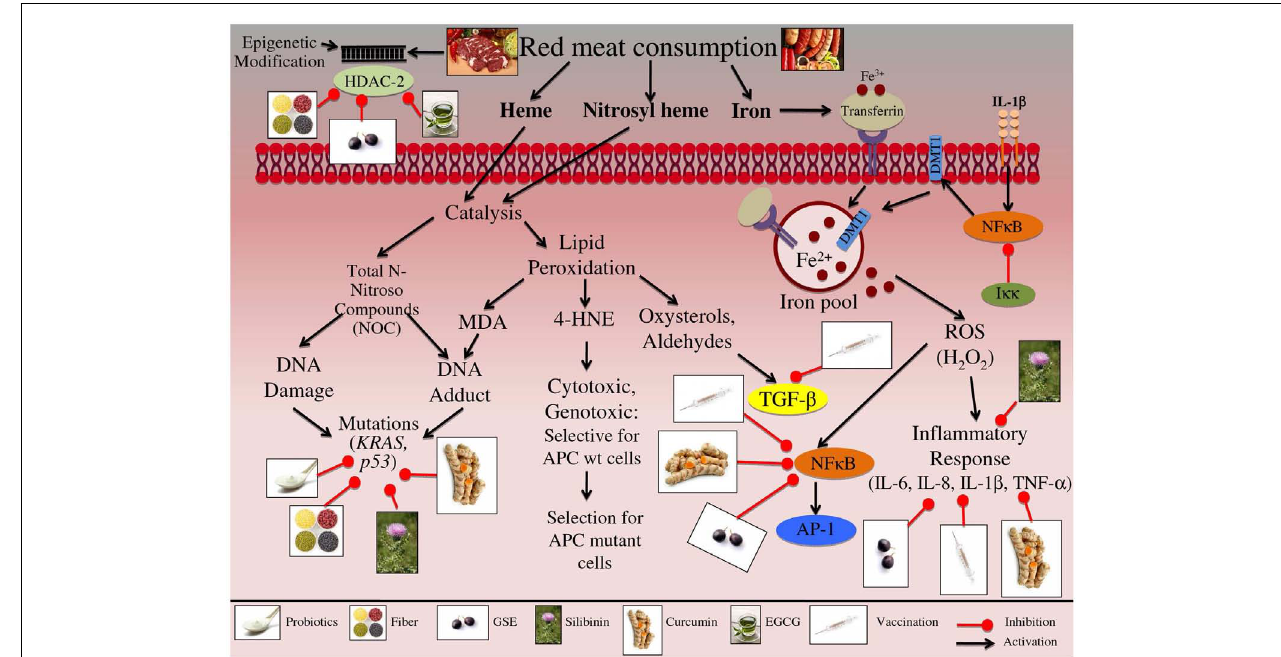
mutated APC gene, resulting in CRC promotion and progression. Additionally lipid peroxidation results in the formation of oxysterols and aldehydes, which further alter hormone signaling, specificallyTGF- β , ultimately resulting in uncontrolled proliferation that contributes to the promotion and progression of CRC. Another major component of red meat is iron, ferric iron (Fe 3 + ) binds to transferrin, resulting in receptor activation and endocytosis. Ferric iron is further converted to ferrous iron (Fe 2 + ) via divalent metal transporter 1 (DMT1), which then contributes to the cell’s overall iron pool. Iron has been linked to the production of reactive oxygen species (ROS), specifically H 2 O 2 ; these reactive species can then up regulate inflammatory mediators, such as NF κ B, IL-6, IL-8, IL-1 β , andTNF- α , leading to the promotion and progression of CRC. Furthermore IL-1 β signaling up regulates NF κ B, which then activates DMT1 iron transporters, resulting in increased levels of ferrous iron within the cell, representing a feed-back loop in iron regulation.The illustration also denotes the modulatory role of lifestyle interventions at various levels on these aberrant signaling pathways.The photographs of lifestyle interventions were sourced and adapted from